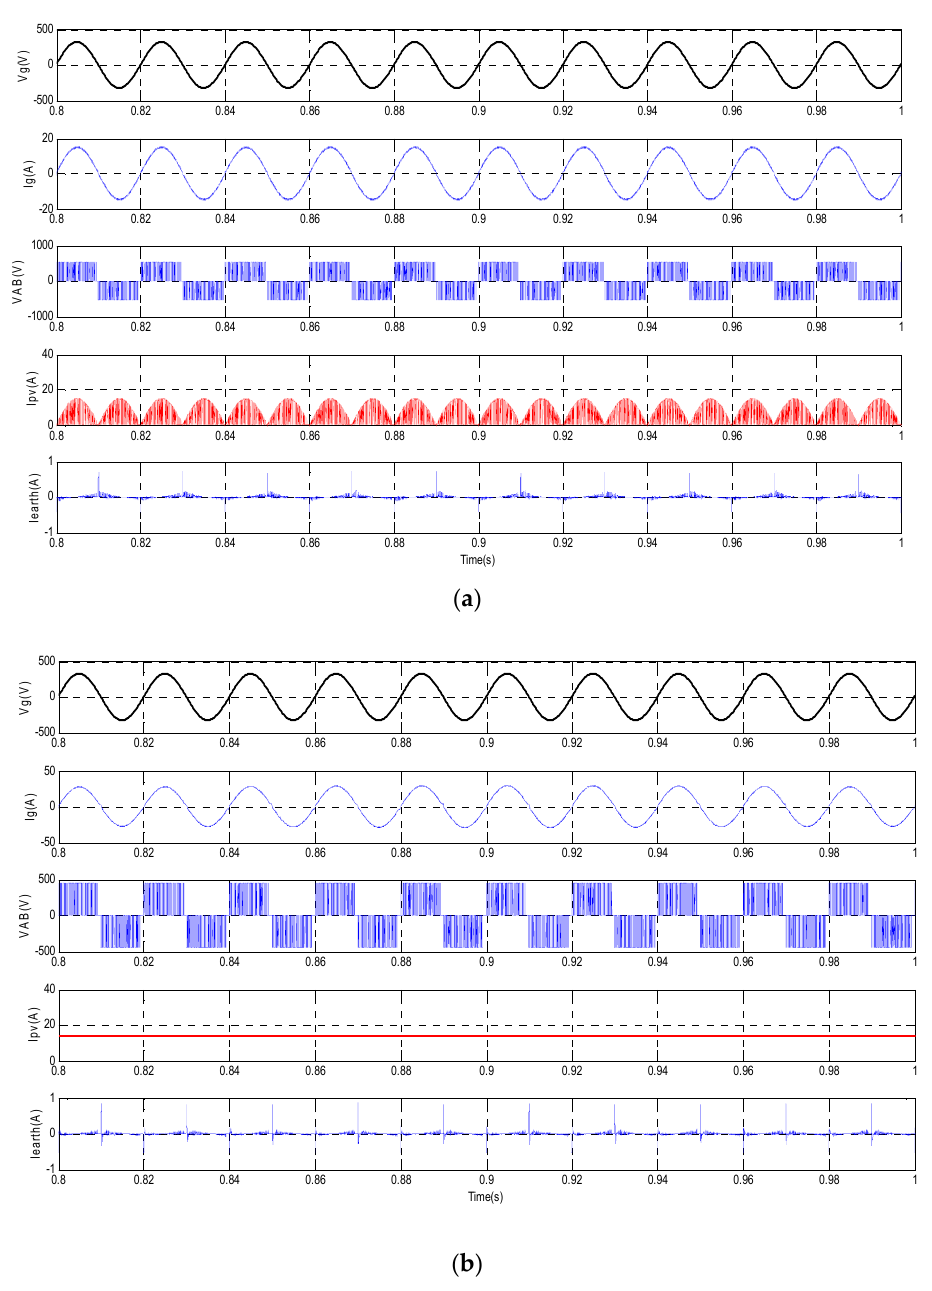
Figure 7. Simulation result of inverter voltage, grid current, PV current, and earth leakage current of the ( a ) conventional H5 inverter and ( b ) H5 proposed inverter.